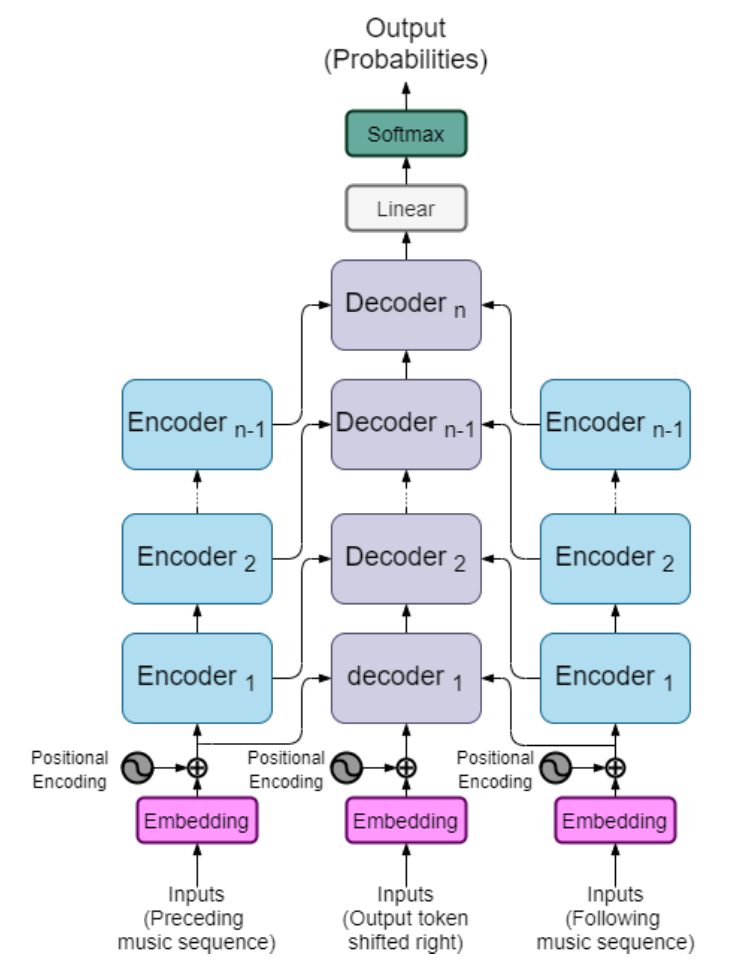
Figure 12. Transformer-based model.